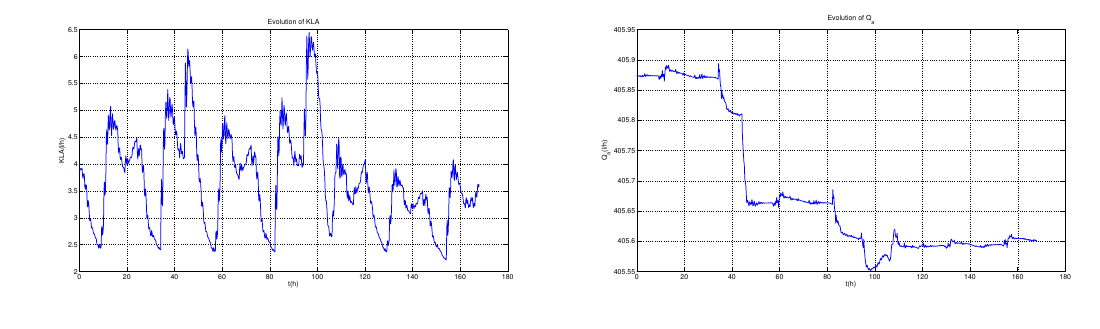
Figure 18. Profiles of K La and Q a for the case 5.